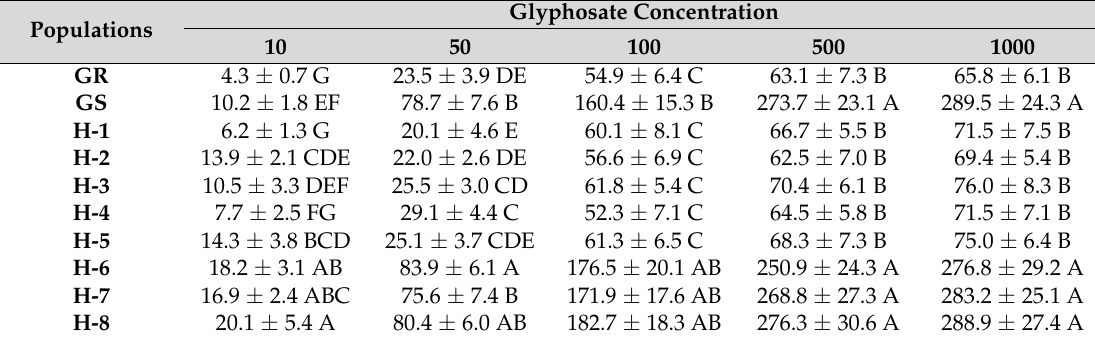
Table 4. Shikimic acid accumulation (µg of shikimic acid g − 1 fresh weight) at different glyphosate concentrations (µM) in C. canadensis populations from Spain (GR and GS) and Hungary (H1–H8).